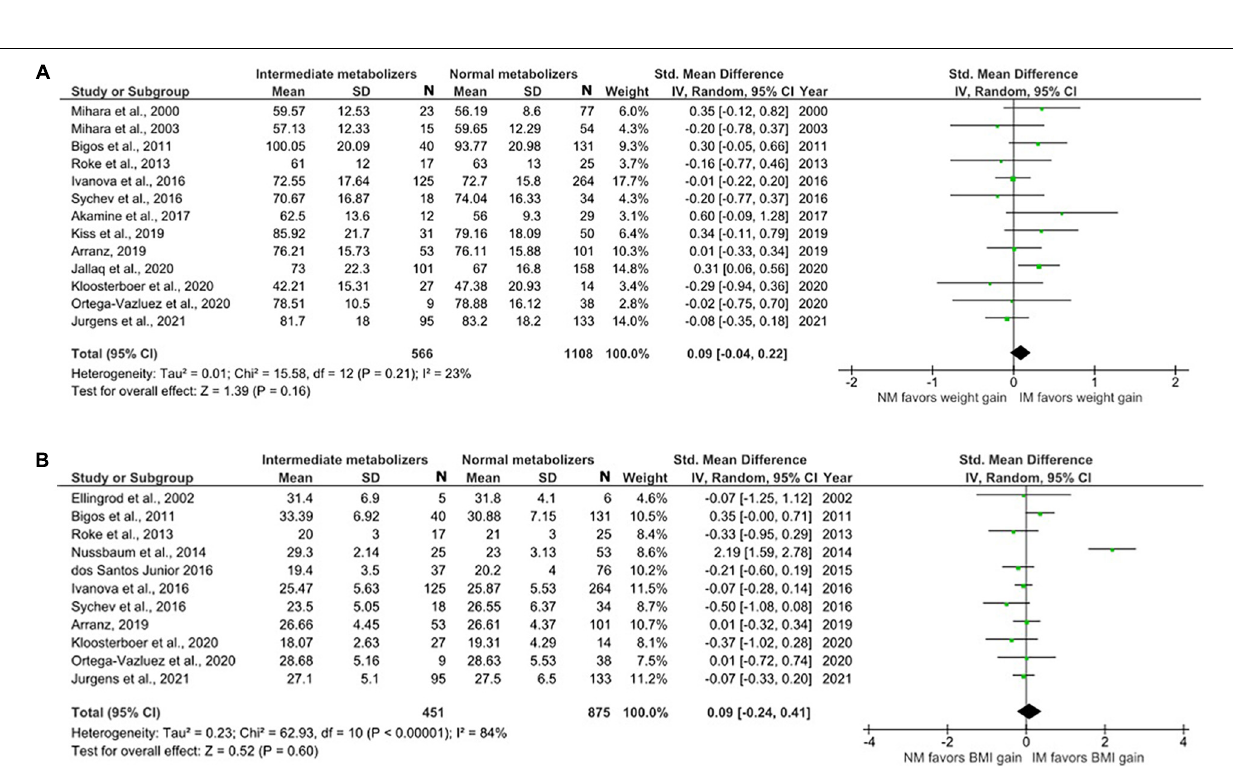
FIGURE 3 | Forest plots comparing (A) standardized mean weight differences (B) standardized mean BMI differences between Intermediate metabolizers and Normal metabolizers. Random effects model and inverse variance method were use. CI, confidence interval; df, degree of freedom; N, number of participants; SD, standard deviation; SMD, standardized mean